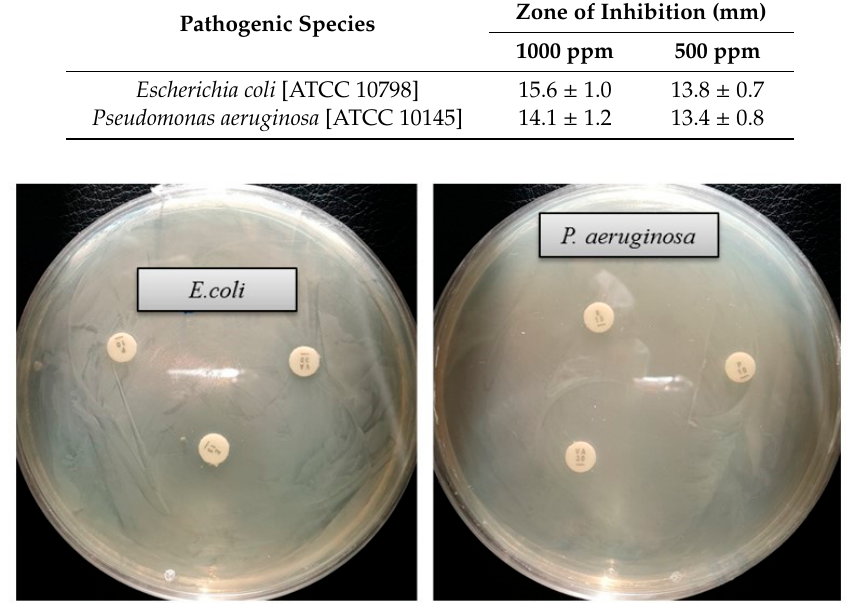
Figure 8. Zones of inhibition of commercial antibiotics against E. coli and P. aeruginosa . Abbreviation: VA (vancomycin, 30 μ g/disc), E (erythromycin, 15 μ g/disc) and P (penicillin, G 10 μ g/disc). Table 4. Antimicrobial activity of eco-friendly synthesized AgNPs against E. coli and P. aeruginosa .